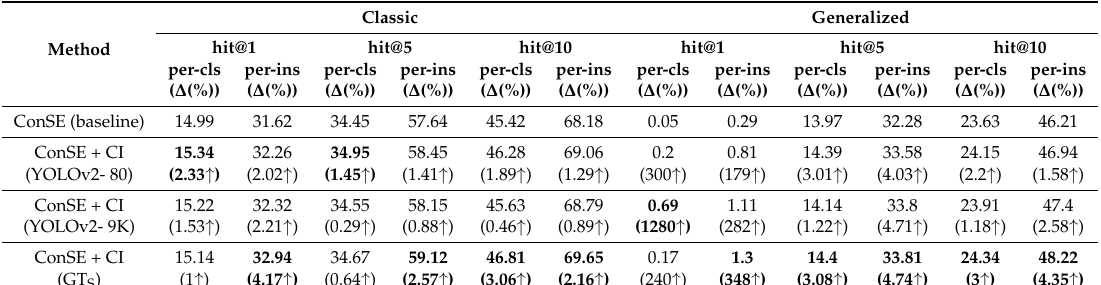
Table 6. A comparative evaluation in the differentiation of sources for surrounding information with the HM path